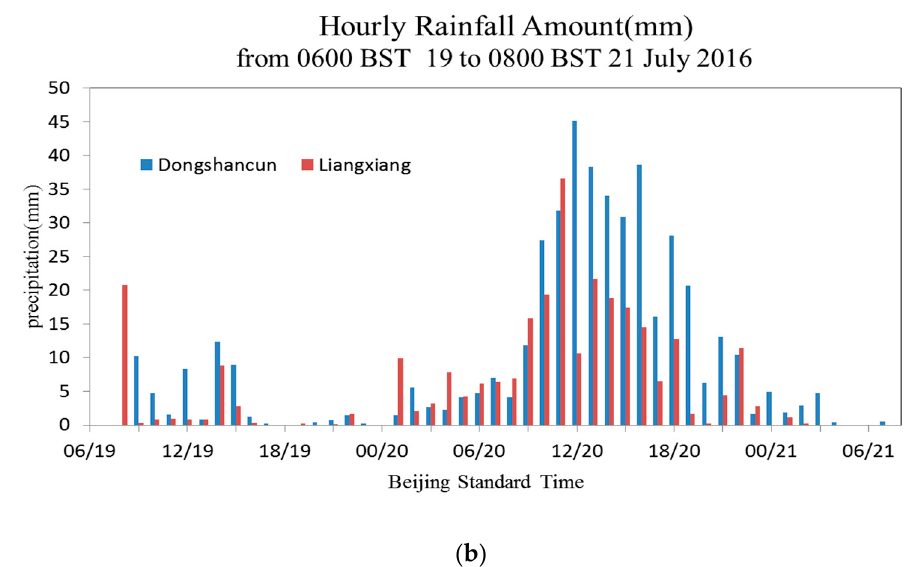
Figure 1. ( a ) The location of Beijing and the weather stations at Dongshancun (marked by a red triangle) and Liangxiang (marked by a black triangular) (BJ: Beijing, TJ: Tianjin, HB: Hebei Province) ( b ) Hourly rainfall amounts (mm) at the Dongshancun and Liangxiang stations (mm).